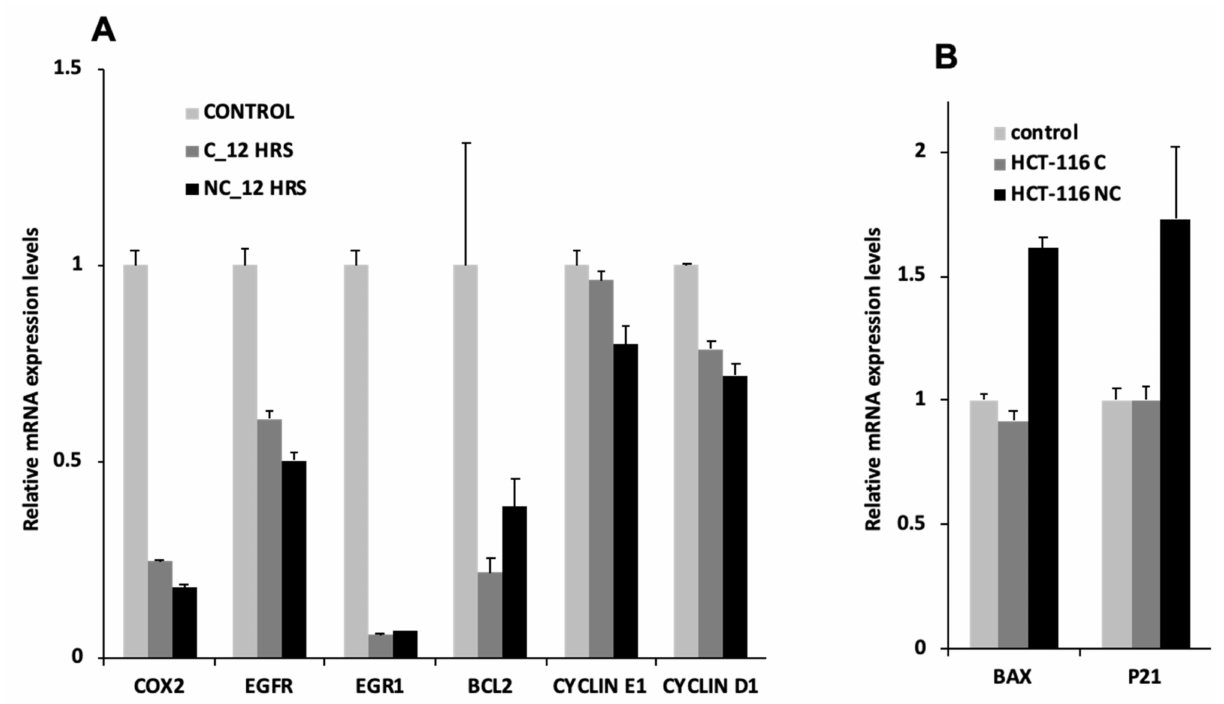
Figure 4. Comparison of the effect of curcumin and NO–curcumin on cell survival genes. ( A ) Statis- tical analysis showing the effect of curcumin and nitrocurcumin on the relative mRNA expression level of different pro-survival genes and ( B ) proapoptotic genes; the results represent data obtained from three different biological experiments performed in